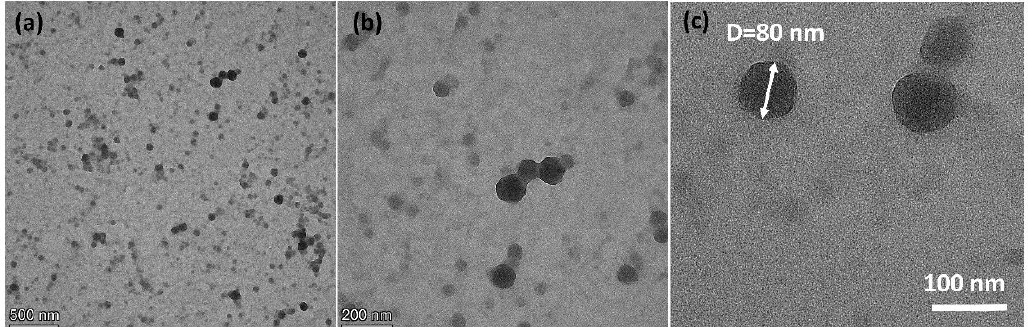
Figure 2. ( a , b ) Transmission electron microscopy images of dispersed PS- b -PAA micelle following the evaporation of water in different scales and ( c ) the averaged diameter of observed micelles is estimated to be around 80 nm.